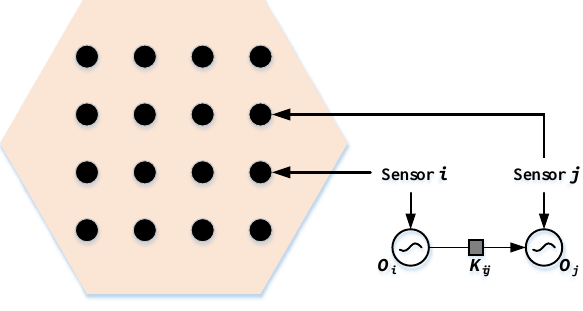
Figure 7. Sensor based unit cell of the proposed ONN for clustering applications. Oscillator i and oscillator j are connected with sensor i and sensor j , respectively. Oscillator i and oscillator j are coupled with K ij , which is one in this system.